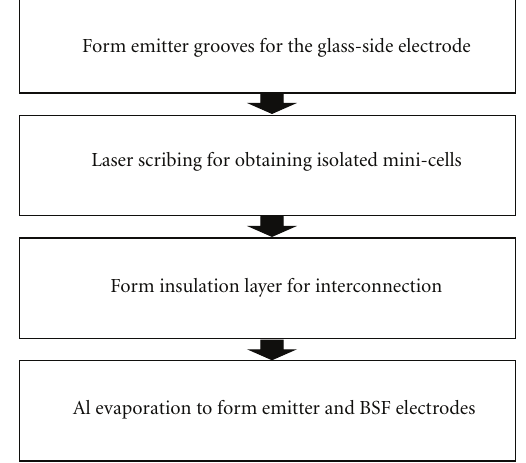
Figure 1: Process flow diagram for the aligned bifacial intercon- nected